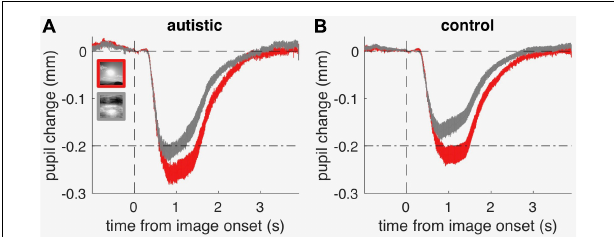
FIGURE 5 | Lack of association between autistic-like traits, as measured by the Autism-spectrum Quotient questionnaire (AQ score), and the difference in pupil response evoked by the sun images and the meaningless control images obtained by phase scrambling. (A) Data from neurotypical adults. (B) Data from children, from both the autistic (filled symbols) and the comparison groups (empty circles). The horizontal continuous black lines show the mean, and the red lines the best-fit linear regression with its 95% confidence interval. Text insets give the Pearson’s correlation (with sample size) and associated p -value and log Bayes